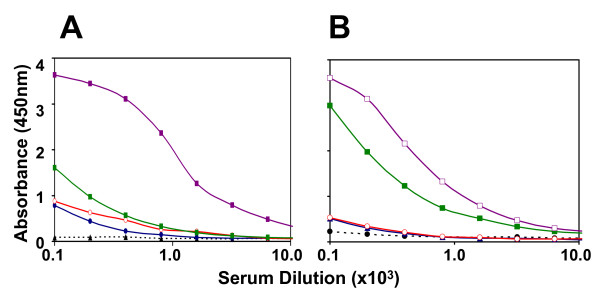
Reactivity of immune sera towards monovalent and bivalent rEDIII proteins. (A) Antibody titers in serial dilutions of murine sera drawn 1 week after priming with rAd-Bg (blue) and 1 week following the first (red), second (green) and final (violet) boosts with pVAX-EDIII-4/2 plasmid were determined in an ELISA using the rEDIII-4/2 bivalent protein as the capture antigen. The black dashed curve indicates ELISA reactivity of control sera, drawn from rAd-C primed/pVAX1-boosted mice after the final boost. (B) Antibody titers in serial dilutions of murine sera drawn from rAd-Bg primed/pVAX-EDIII-4/2 boosted mice, one week after the final boost. ELISA was performed using rEDIII-1 (blue), rEDIII-2 (green), rEDIII-3 (red) and rEDIII-4 (violet) proteins as capture antigens. The black dashed curve indicates ELISA reactivity of control sera using a mixture of the four rEDIII proteins as capture antigen. All ELISA values in this experiment represent the average of two separate determinations.